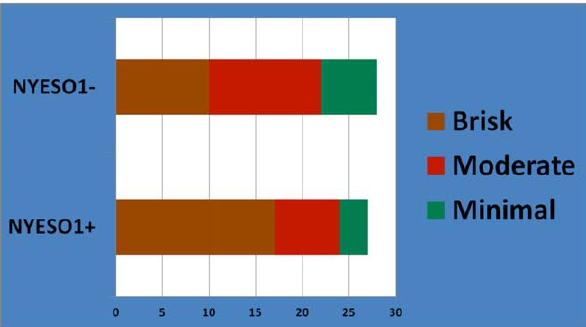
Figure 5. The relationship between NY-ESO-1 expression and degree of CD8 tumor infiltrating lymphocytes in TNBC. This figure shows the relationship between NY-ESO-1 expression and degree of CD8 tumor infiltrating lymphocytes in TNBC.